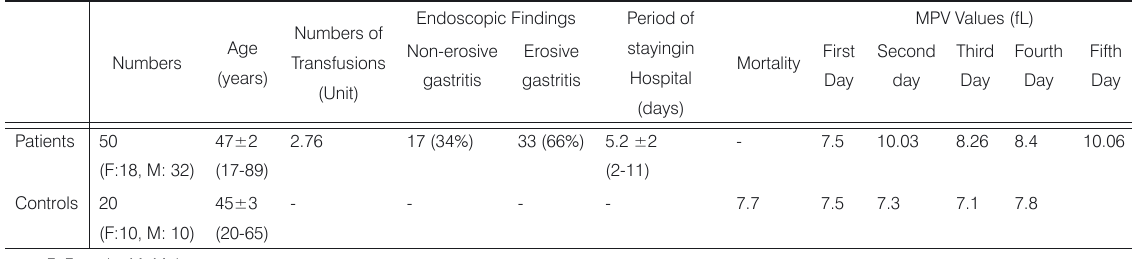
Figure 1. MPV (mean platelet volume) changes during the first five days of the bleeding. The MPV changes at the first five days of